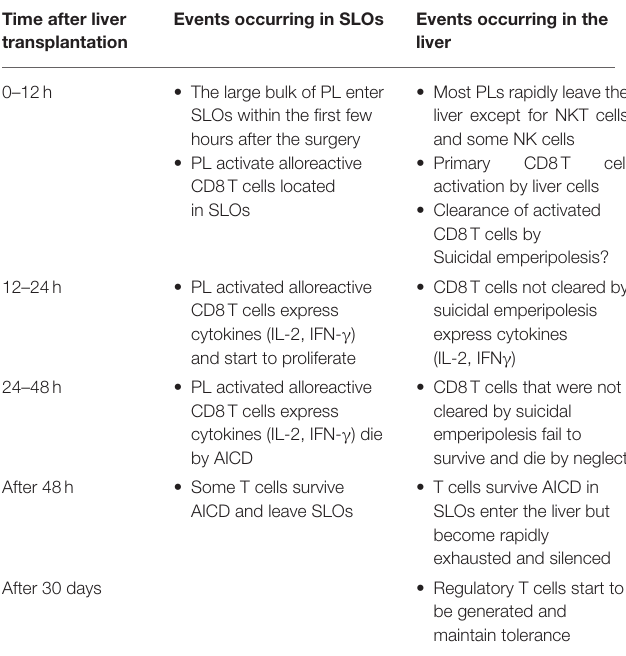
TABLE 1 | Summarizing the main features of the induction phase of liver transplant tolerance. Time after liver Events occurring in SLOs Events occurring in the transplantation